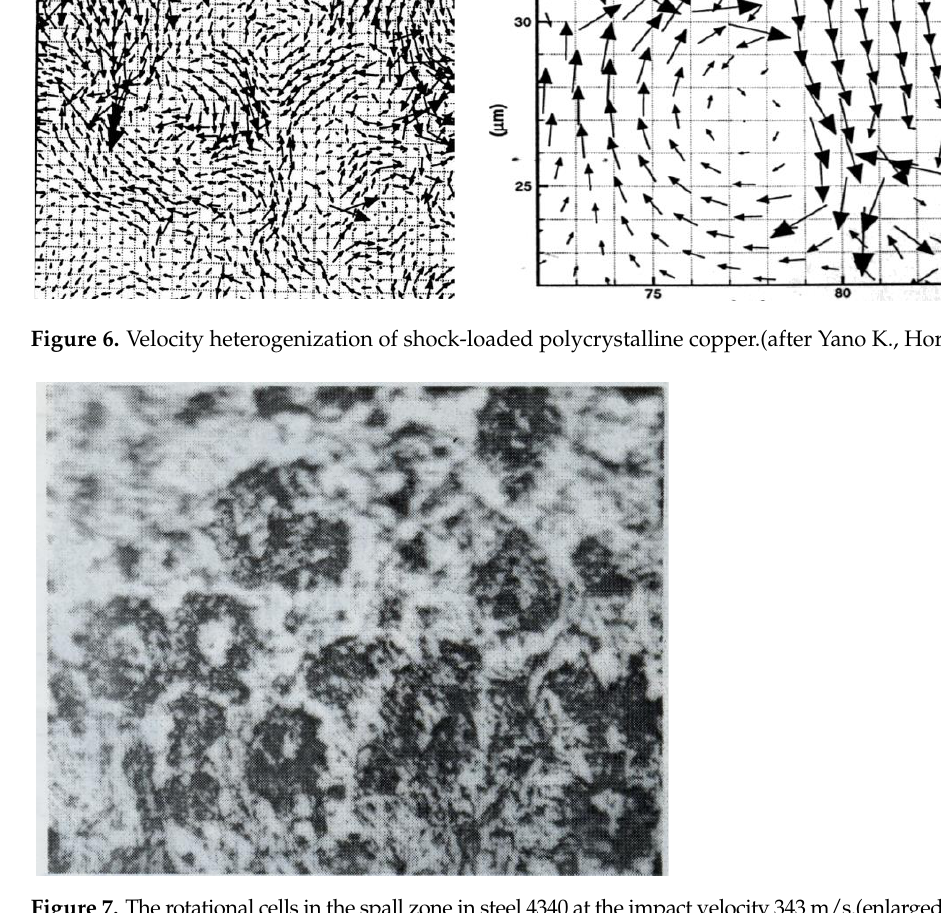
Figure 7. The rotational cells in the spall zone in steel 4340 at the impact velocity 343 m/s.(enlarged 1000 + ).